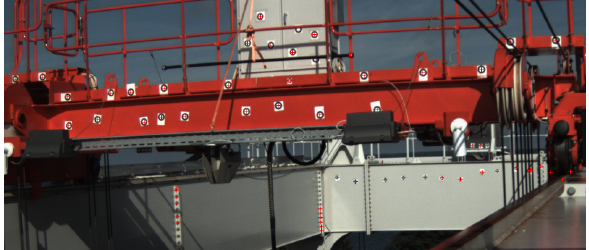
Figure 5: 3-D points (red plus signs) projected onto the image after deformation. The image has been cropped (zoom in to see the red plus signs).